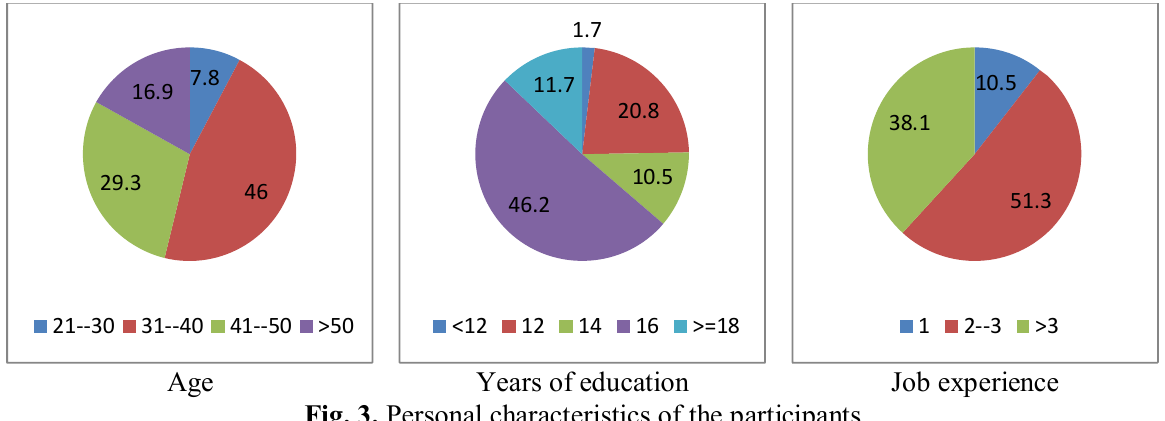
Fig. 3. Personal characteristics of the participants